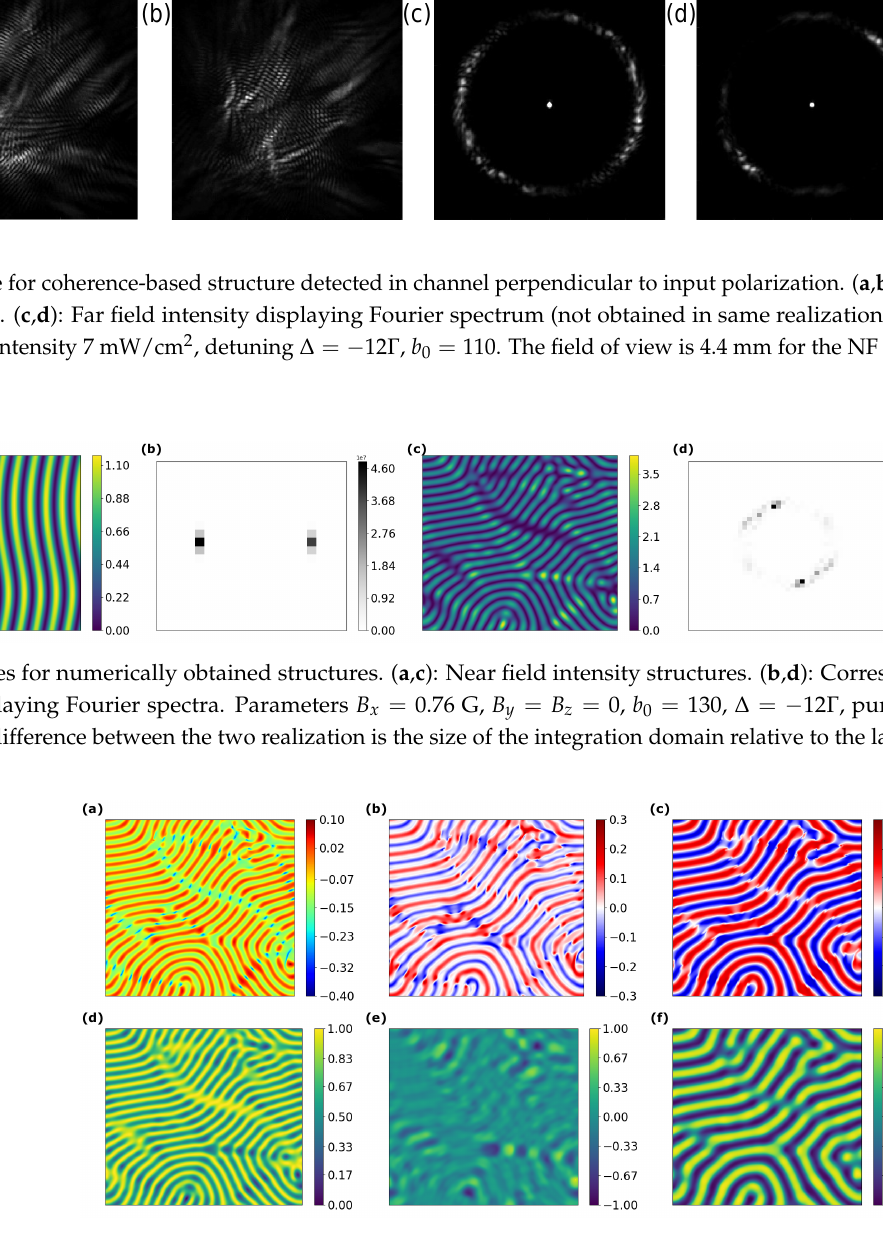
Figure 14. Upper row: Spatial distribution of atomic variables corresponding to the structures in Figure 13c: ( a ) real part of coherence u , ( b ) imaginary part of coherence v , ( c ) orientation w , Lower row: Stokes parameters of backward beam, ( d ) S 1 , ( e ) S 2 , ( f ) S 3